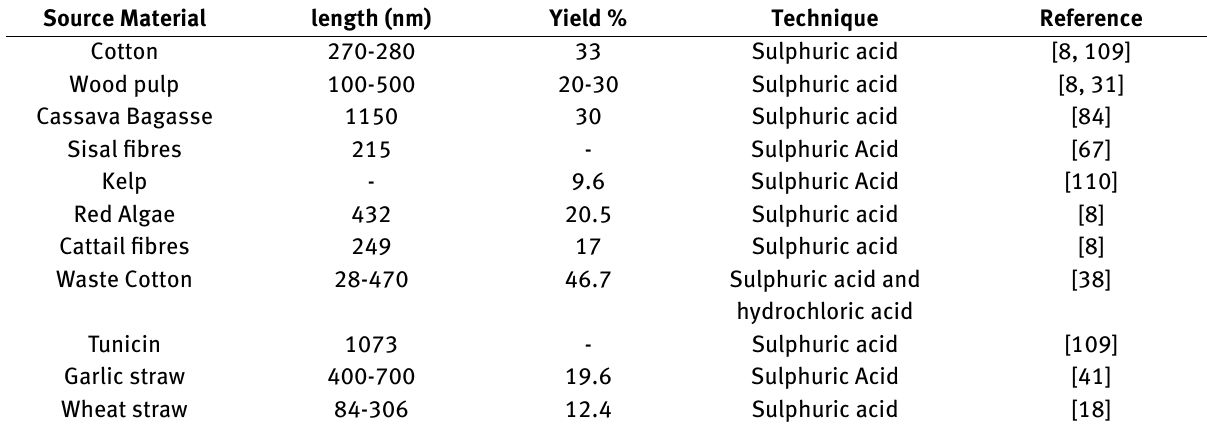
Table 1: Comparison of the size and yield of CNC extracted from different source materials. Source